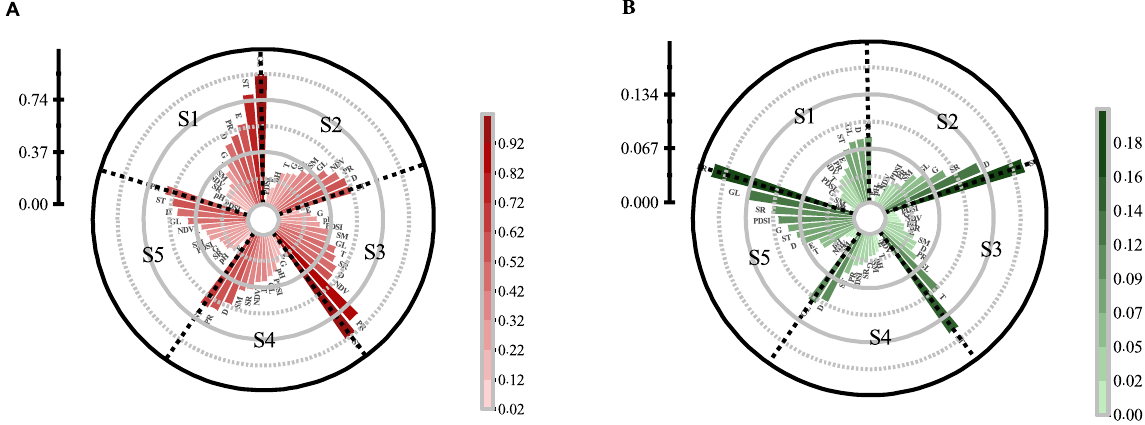
Figure 2. The results of the Jackknife test of variable importance. ( A ) The training gains of each variable if the model was run in isolation, and the variable had useful information when the gain was high. This is useful for identifying the variables that contribute the most individually; ( B ) The reduction in gains when the variable is excluded compared to all variables. If it reduces the gain most when it is excluded, the variable has unique information. Additionally, intrinsic features include GL, ST, D, pH, E, and G; variable features include PR, SR, SM, NDVI, PDSI, and T.